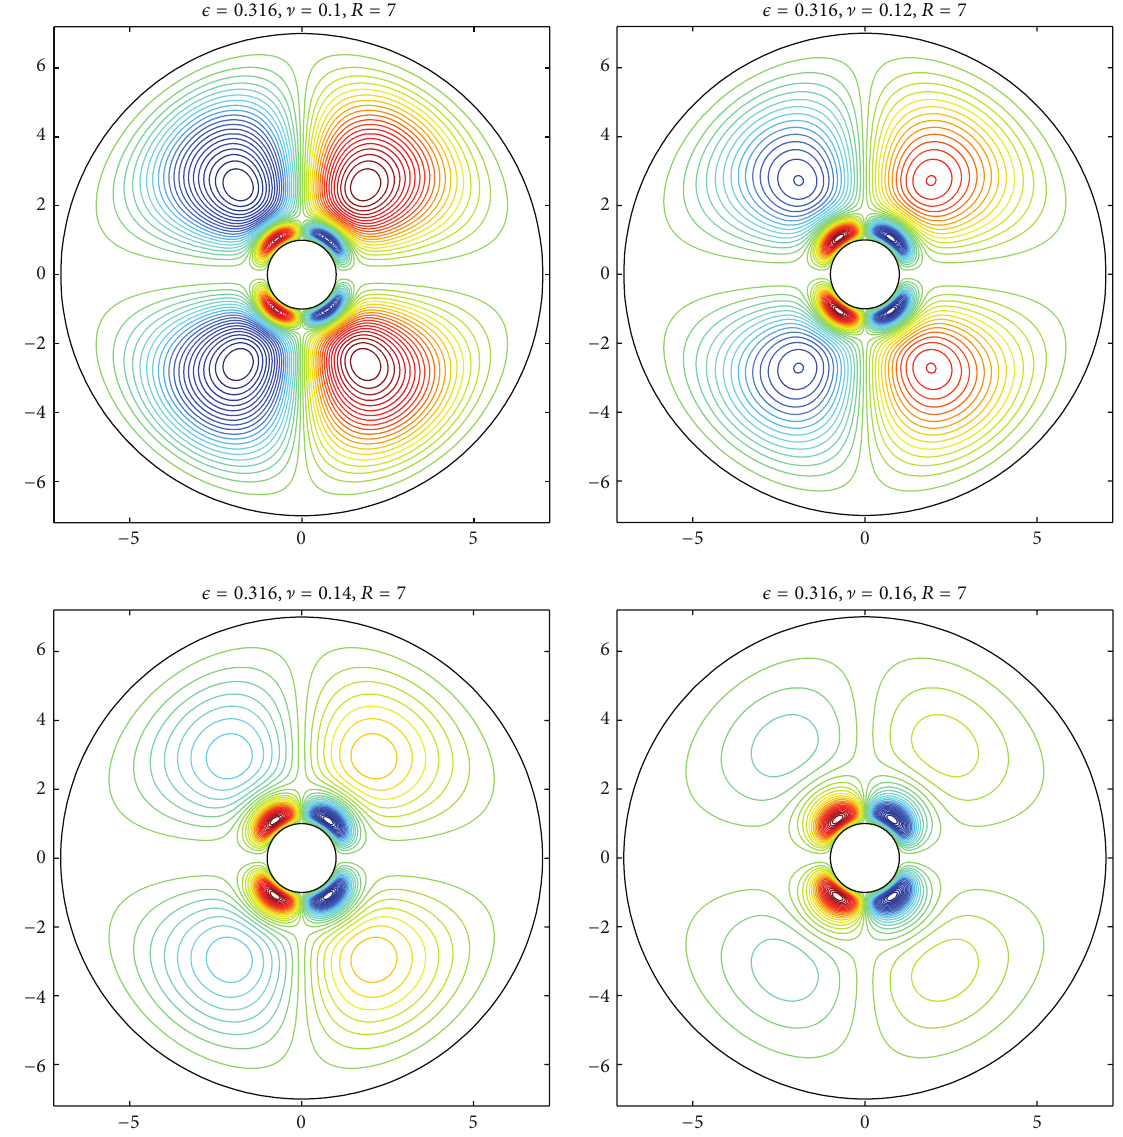
Figure 3: Steady streaming between two